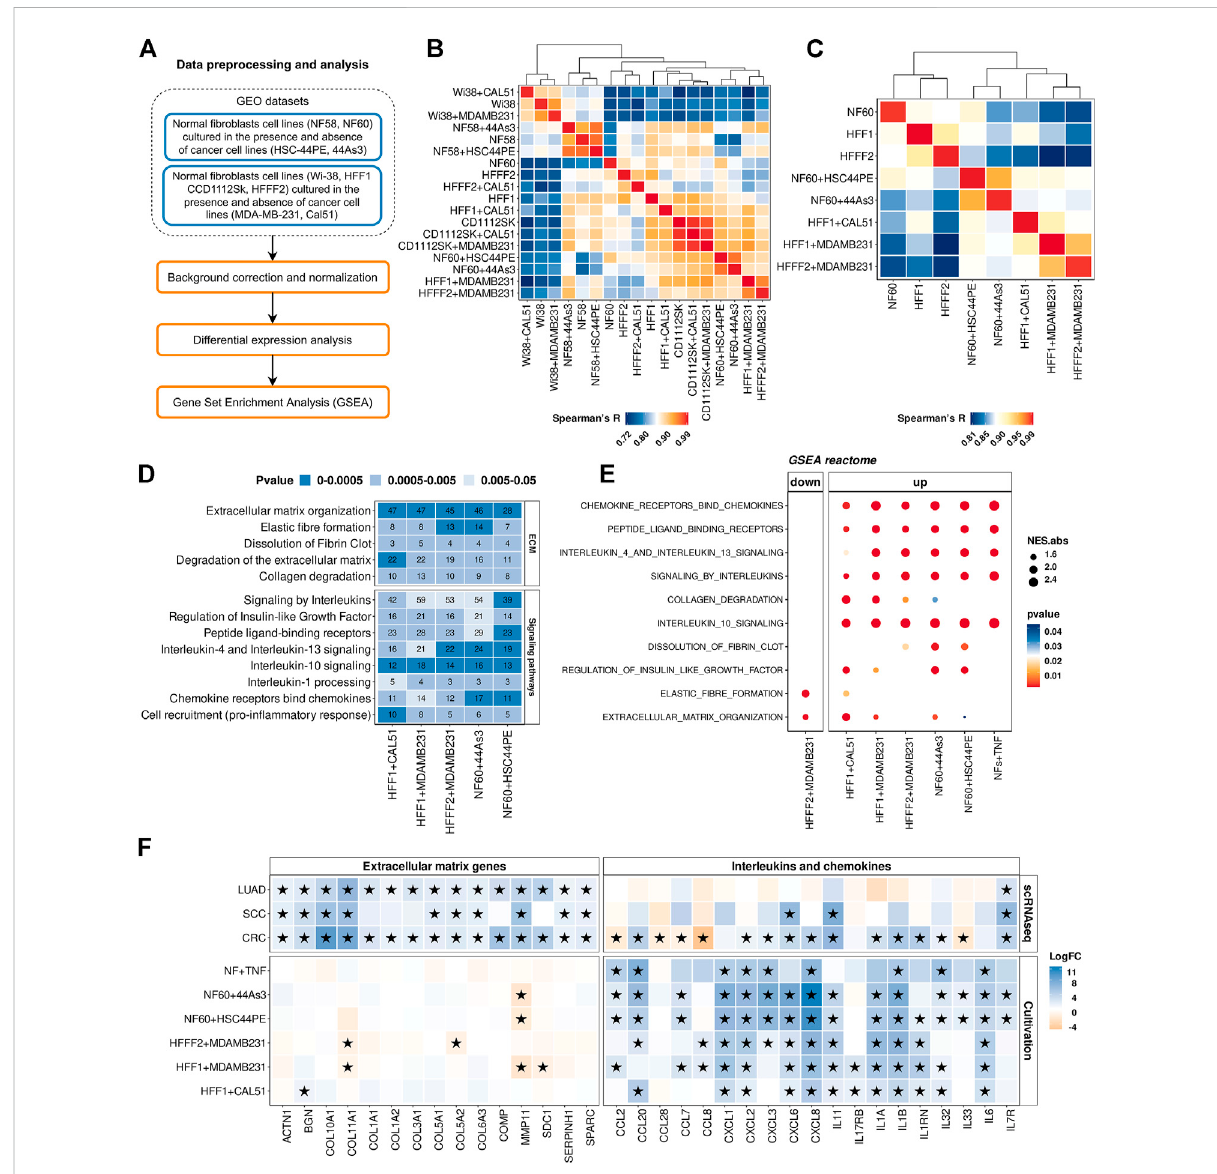
FIGURE 4 Comparison of gene expression between CAFs and NFs within the cult-CAFs-NFs approach. (A) Work fl ow for comparing gene expression between normal fi broblasts cultured in the presence and absence of cancer cell lines. (B) The Spearman ’ s correlation analysis of gene expression pro fi lesofNFandCAFsamples(414CAFmarkergenes).Spearman ’ sRvaluesarethemediansofallpairwiseSpearman ’ scorrelationcoef fi cientvalues between samples. The sample order is based on single-linked hierarchical clustering of the matrix, shown by the dendrogram. (C) The same Spearman correlation matrix as in point c, only for samples selected for further analysis. The sample order is based on single-linked hierarchical clusteringofthematrix,shownbythedendrogram. (D) HeatmapoftheReactomePathwayenrichmentanalysis.Itrepresentsthegenesdifferentially expressed between CAFs and NFs. The x-axis shows the types of tumor; the y-axis shows the signaling pathways. The numbers in the boxes are the number of genes associated with the certain pathway for the given type of tumor, with a p -value < 0.05. (E) Dotplots of GSEA results illustrating the enrichment of the common Reactome pathway gene sets identi fi ed by the enrichment analysis in the cult-CAFs-NFs approach. (F) Heatmap showingdifferencesinthegeneexpressionlevelinCAFsrelativetoNFsinsc-CAFs-NFsandcult-CAFs-NFsapproaches.Ontherightisaheatmapfor cytokine and interleukin genes. The left heatmap is for genes involved in processes of extracellular matrix organization. Asterisks indicate signi fi cant differences in the expression ( | logFC | ≥ 1 and FDR < 0.05). Blue = increased gene expression in CAFs compared to NFs, orange = decreased gene expression in CAFs compared to NFs. Types of tumor: CRC- colorectal cancer, LUAD — lung adenocarcinoma, SCC — squamous cell